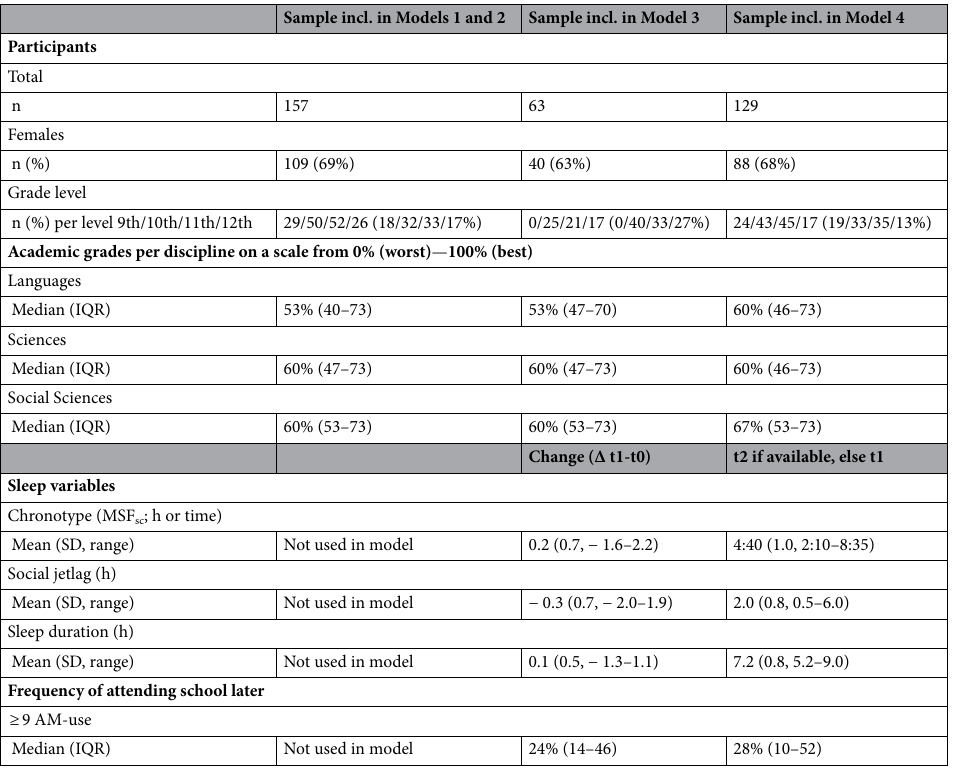
Table 2. Composition of study cohorts. Displayed are cohort characteristics after standard filter criteria. Grades were provided by the school registry. Grade levels are taken from t1. n number of individuals, SD standard deviation, IQR interquartile range, conv.